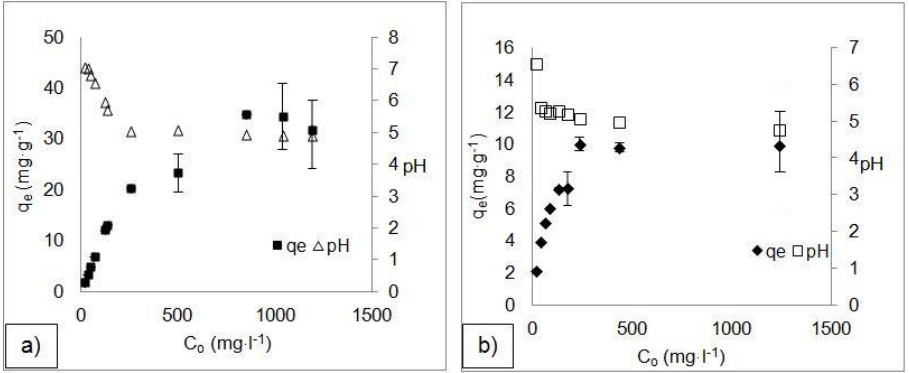
Figure 4. Effect of initial concentration on adsorption of ( a ) Pb and ( b ) Cu in aqueous solution.